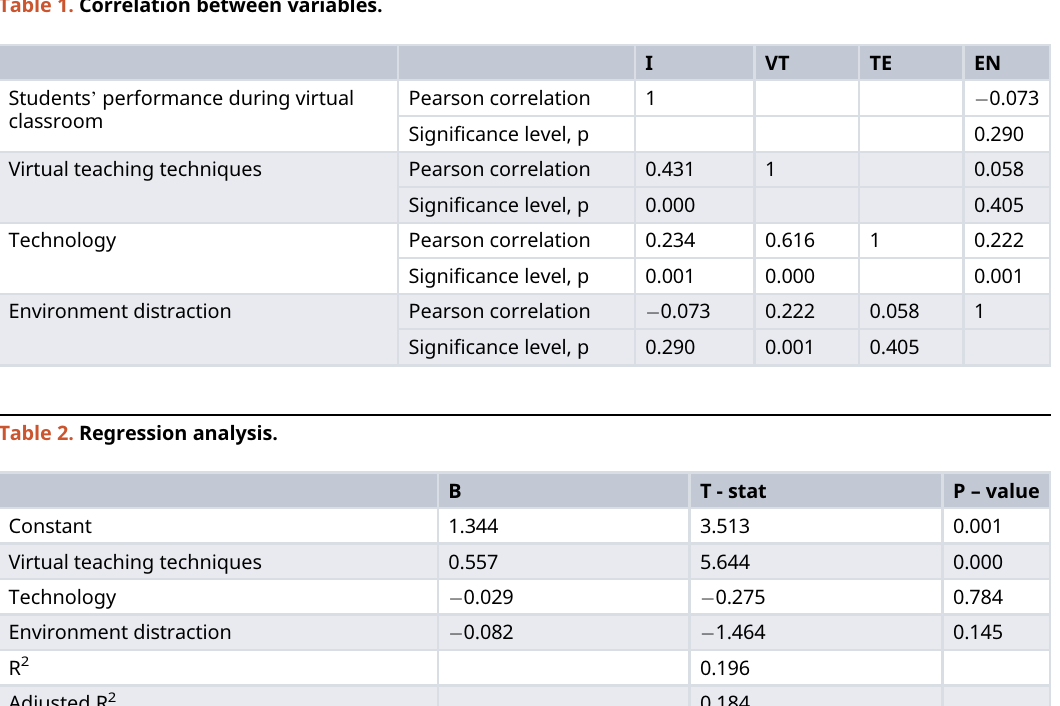
Table 1. Correlation between variables.